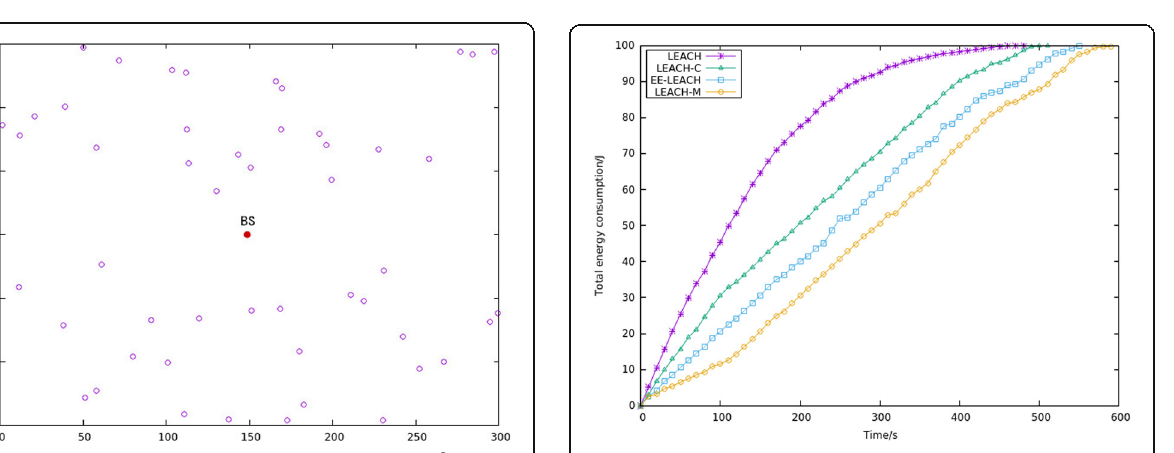
Fig. 7 The distribution of 50 sensor nodes in a 300 × 300m 2 network topology